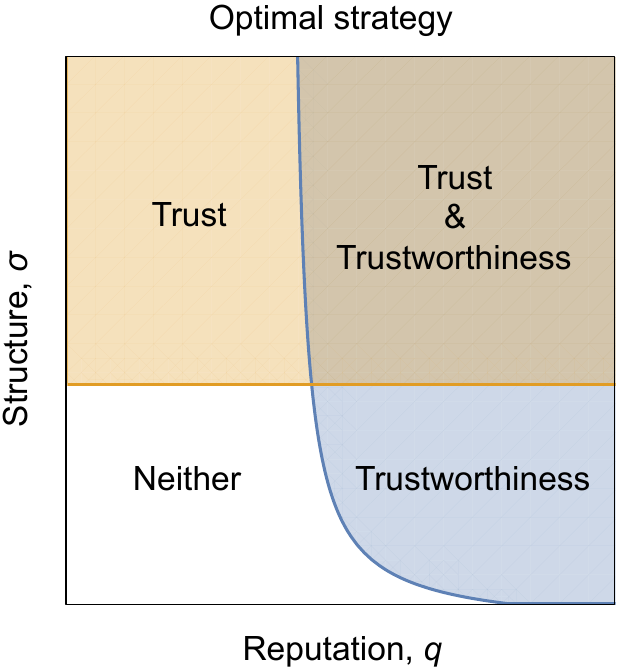
Figure 5. Structure and reputation act synergistically to allow the evolution of trust and trustworthiness.